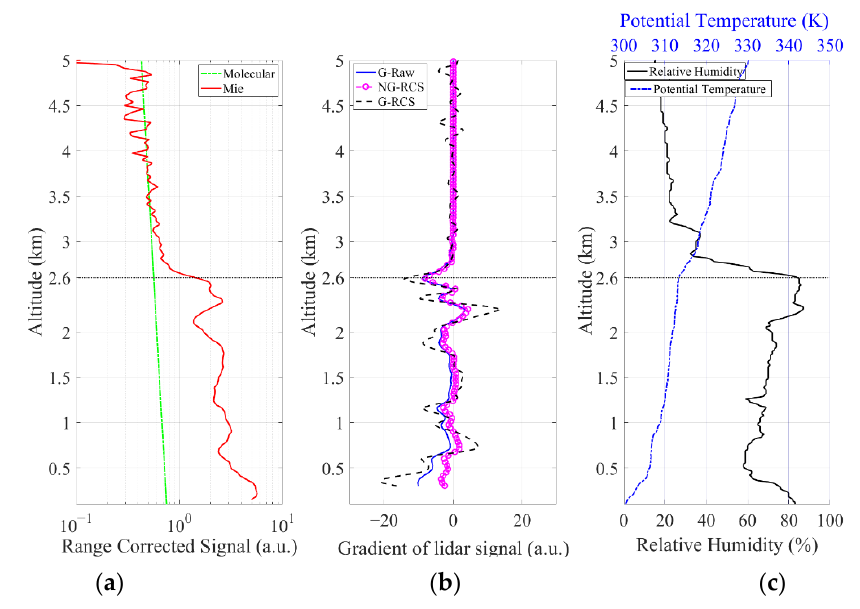
Figure 7. ( a ) Profiles of RCS and atmospheric molecular signal at 7:15, 23 July 2019; ( b ) Gradient profiles obtained by G-Raw, NG-RCS, and G-RCS; ( c ) Profiles of PT and RH obtained by GTS1 Digital Radiosonde at 7:15, 23 July